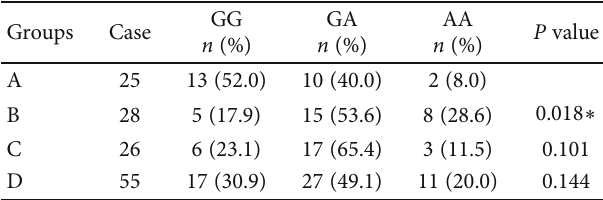
Table 3: Comparison of genotype frequencies of rs682429 in LRP5 among groups.